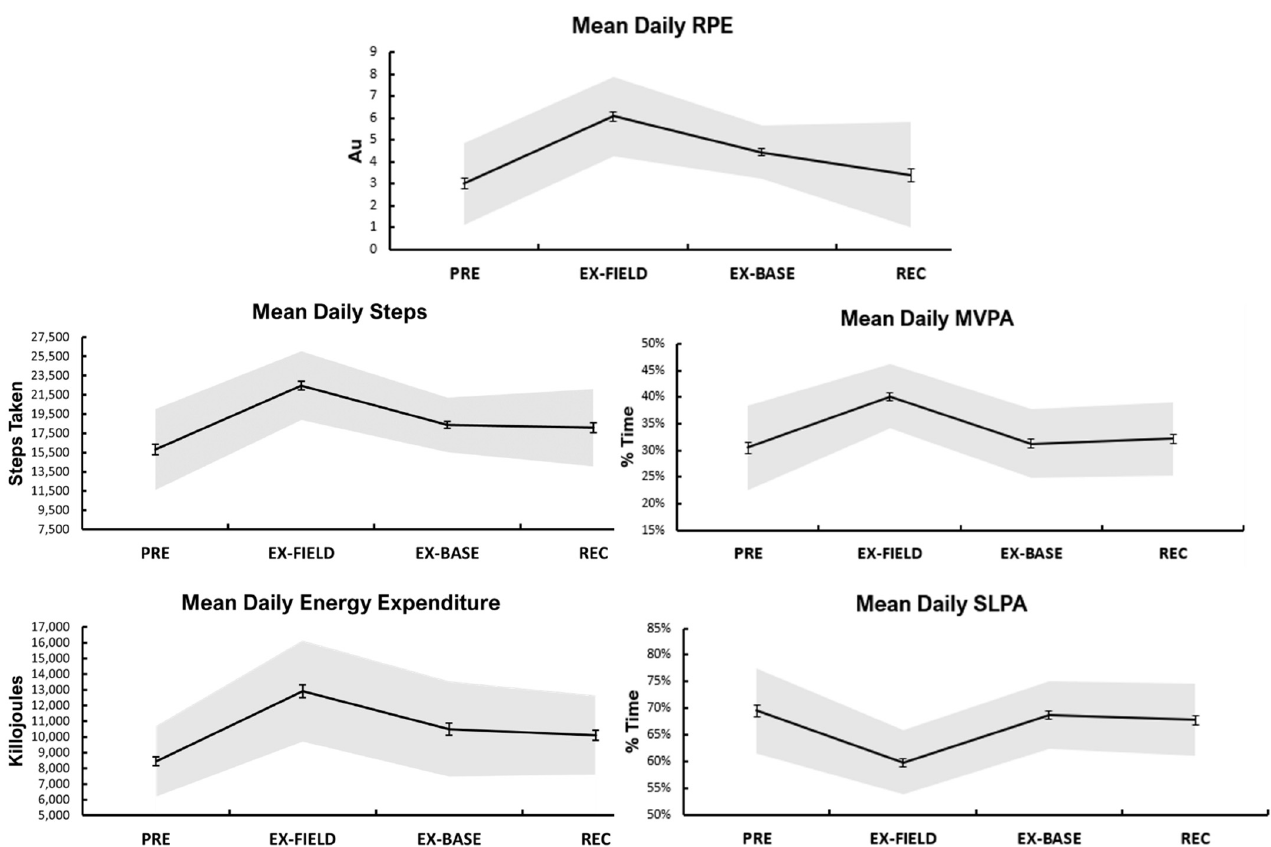
Figure 2. Means per study phase ( ± SE) for physical workload. NOTE: RPE, rating of perceived exertion; MVPA, moderate to vigorous physical activity; SLPA, sedentary to light vigorous activity; Au, arbitrary units. All variables significantly changed across the four study phases p < 0.05.